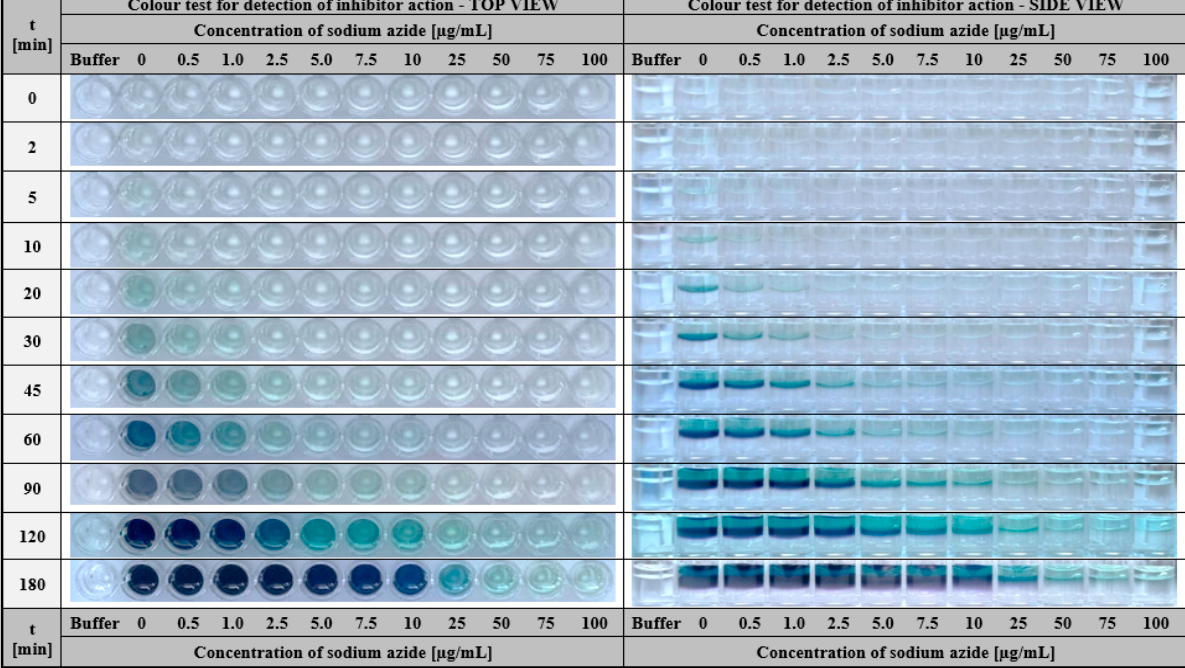
Figure 13. The visual response obtained after a different time of hydrogel-based test with immobi- lised laccase from T rametes versicolor (final concentration 200 µg/mL) performed for a fixed concentration of ABTS (1.5 mg/mL) containing different concentrations of sodium azide (0.5–100 µg/mL).